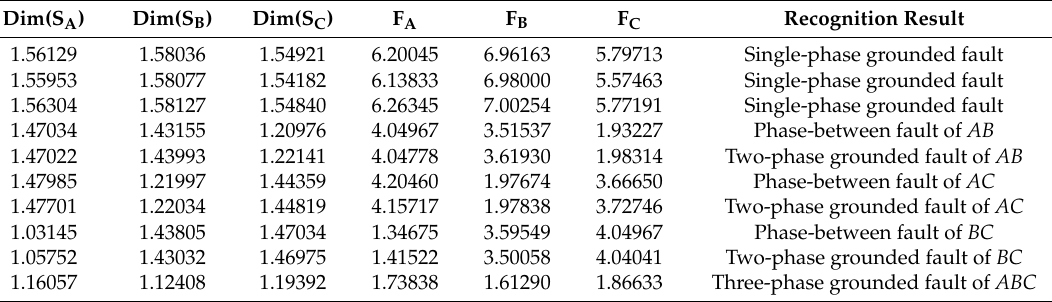
Table 5. IFBD recognition with initial angle of 30° and fault resistance of 30 Ω .